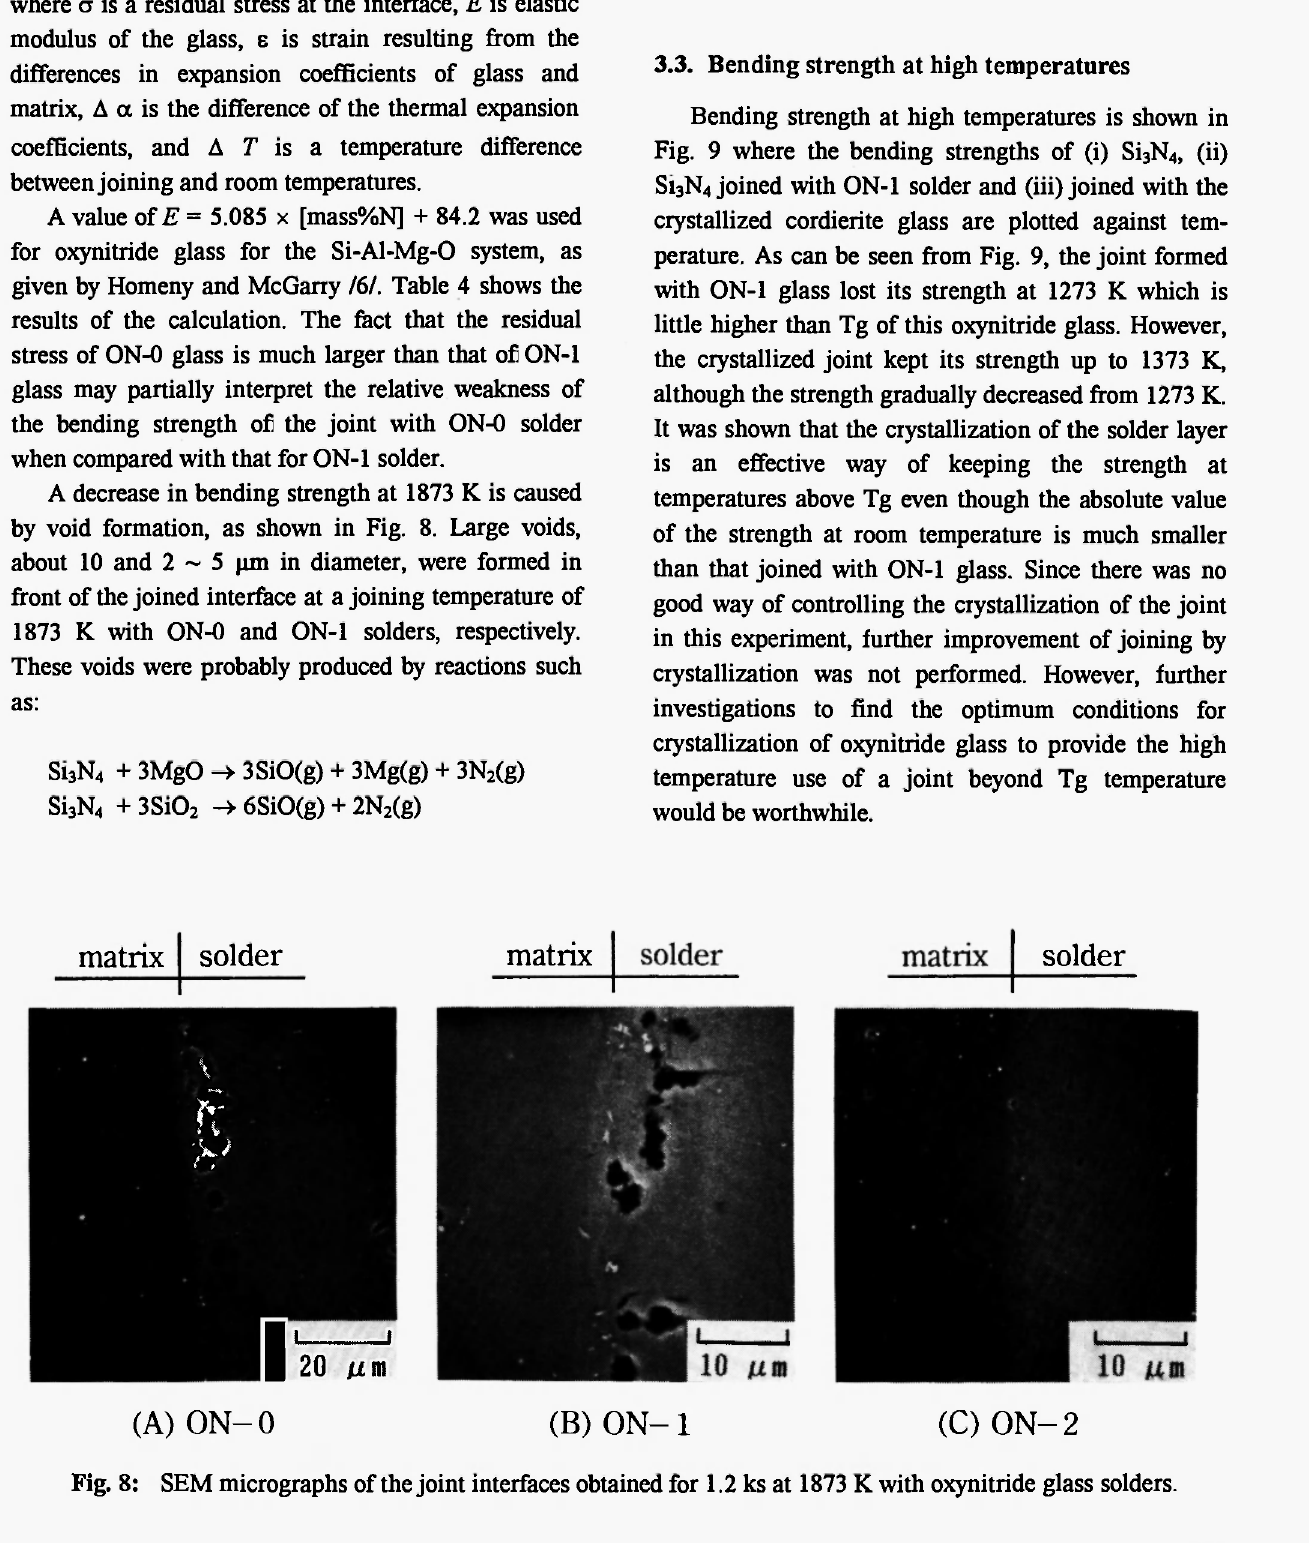
Fig. 8: SEM micrographs of the joint interfaces obtained for 1.2 ks at 1873 Κ with oxynitride glass